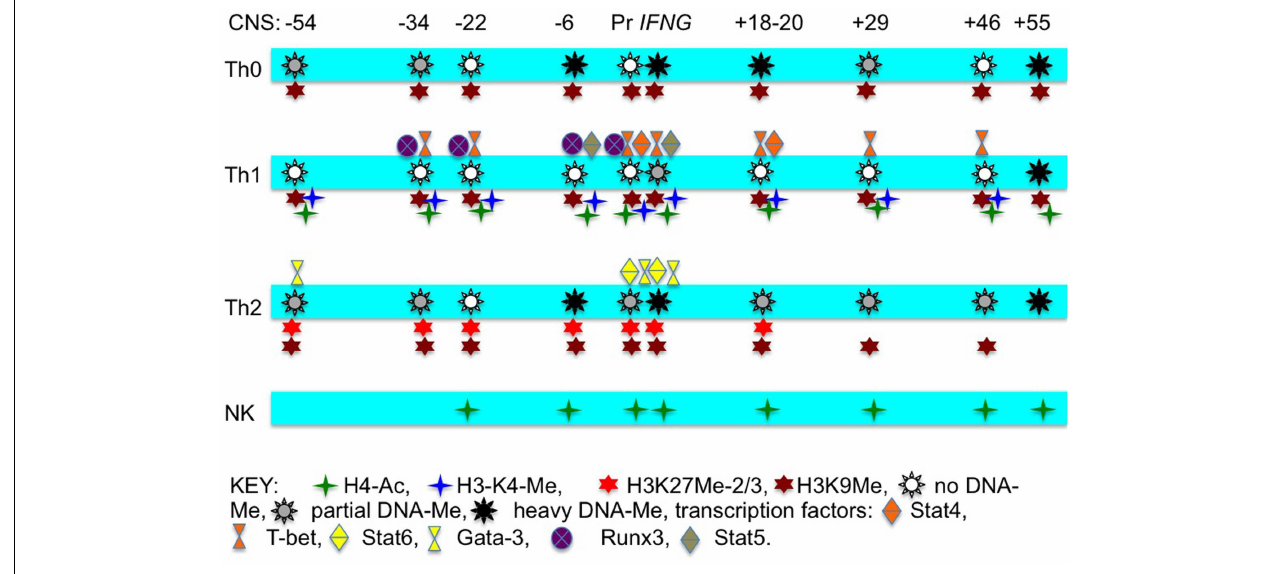
FIGURE 1 | Schematic illustrating transcription factors that bind to individual CNS across the IFNG locus, histone “marks” across the locus, and degree of CpG dinucleotide methylation at the different CNS inT cell and NK cell lineages .